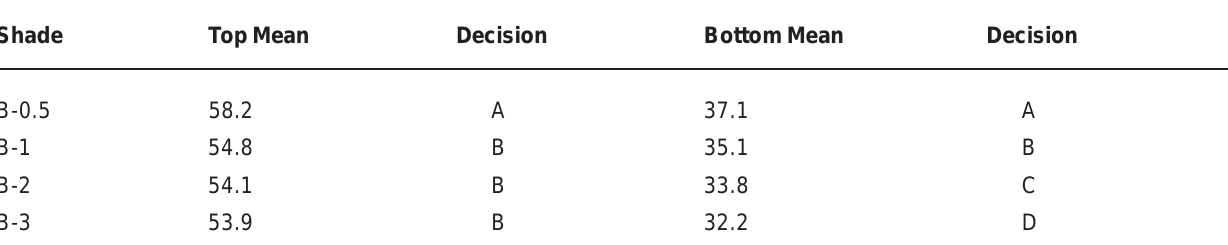
DMS (top) = 0.0235 DMS (bottom) =